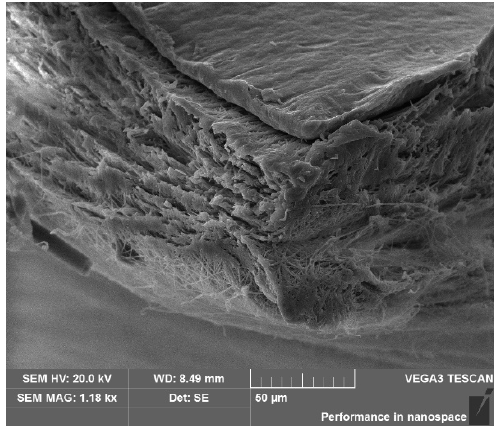
Figure 4. The sectional view of sample PT10Zad.